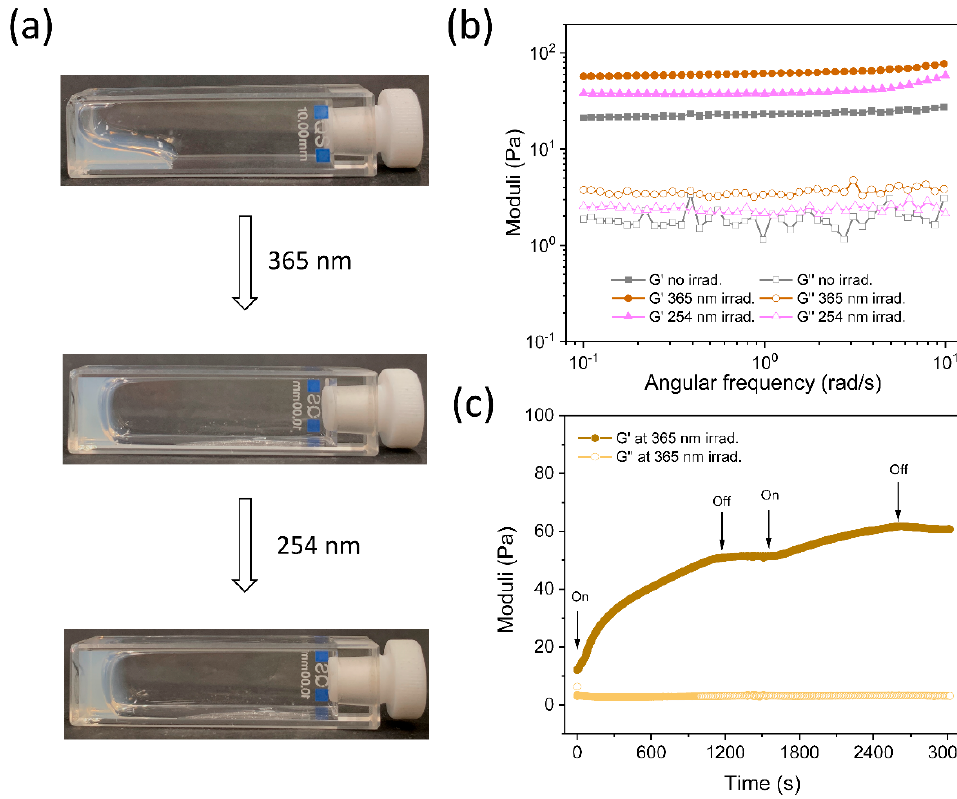
Figure 7. Rheological measurements of UV-induced crosslinked hydrogels. ( a ) Optical images of the mixed solution of 30 mg/mL of OEG bis-urea amphiphile with 10% Cou-crosslinker before and after UV irradiation. ( b ) Frequency sweeps of the mixed solution before and after UV light irradiation of 365 nm and 254 nm at a fixed oscillation strain of 1.0%. ( c ) Time-dependence of in situ measurements of the photo-crosslinked hydrogel by turning on or off UV light (365 nm, 7.2 mW/cm 2 ). The measurement temperature was set at 20 °C.